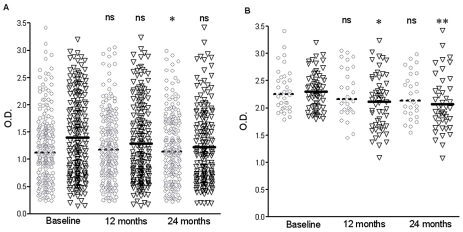
Effect of LNs on sand fly exposure, adjusted for non-endemic controls.Individual ELISA Optical Density (OD) per immunological survey (baseline, 12 and 24 months follow-up) for intervention (long-lasting insecticidal net, LN – black triangles) and control clusters (grey circles), for Phlebotomus argentipes (Panel A) and P. papatasi (Panel B). Individuals with no ELISA results or below the average non-endemic control OD+2×S.D. cut-off values (0.9 for P. argentipes and 1.8 for P. papatasi) at baseline were excluded. The geometric means ELISA OD are represented as a solid line for LN and dotted line for control groups. The Mann Whitney t-test was used to compare 12 and 24 month follow-up samples compared to their corresponding baseline values, asterisks denote statistical significance (*, P<0.05; **, P<0.005; *, P<0.005; ns, not significant P>0.05).